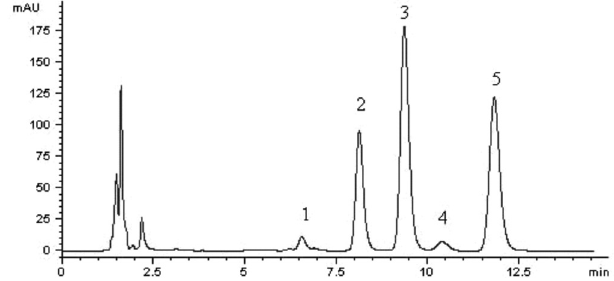
FIGURE 2B - Representative chromatogram of plasma spiked with hesperidin, caffeic acid, ferulic acid, p -coumaric acid and IS.